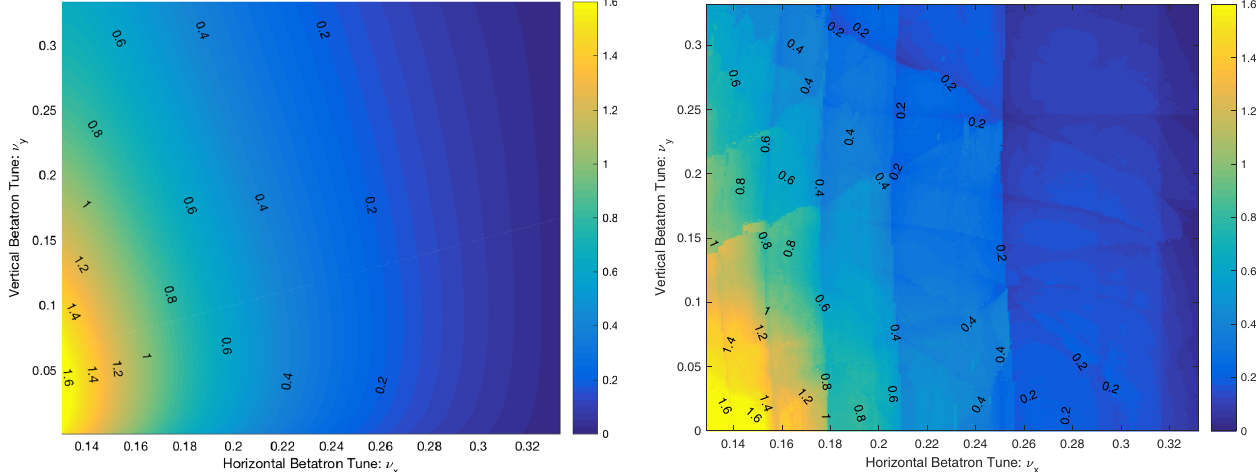
FIG. 17. A comparison of tune scan of the calculated (left) and simulated (right) dynamic apertures in the normalized coordinates ffiffiffiffi p L divided by ϕ